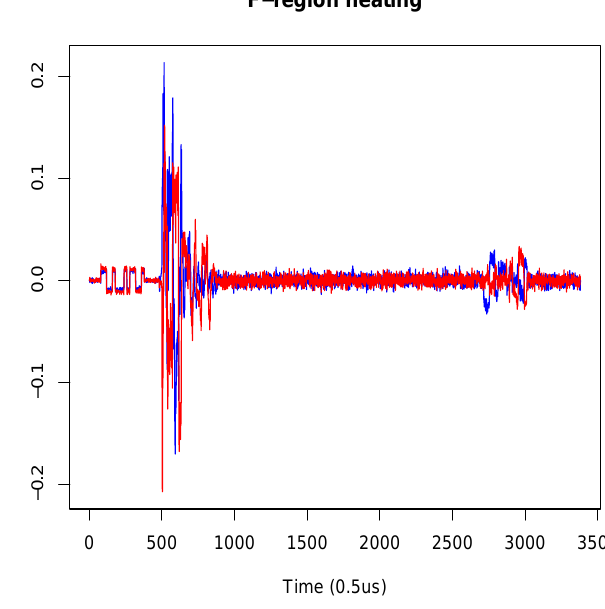
Fig. 2. Modulus of raw VHF measurements from a strong narrow layer in the F-region. Two meteor head echos can also be seen be- low the F-region backscatter. The strong echos below are ground clutter echos. Origin of time is the end of the TX pulse.